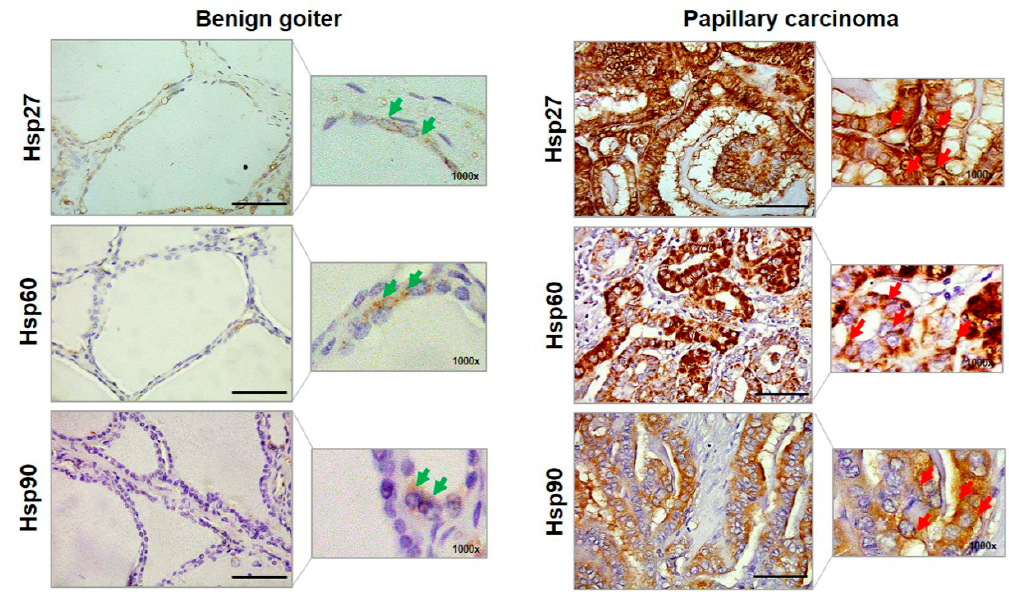
Figure 2. Representative images of the immunohistochemistry of benign goiter and papillary carcinoma for Hsp27, Hsp60, and Hsp90. Larger images were acquired at a magnification of 400× (scale bar: 100 µm); smaller images at 1000× allowed a better visualization of the cellular localization of immunopositivity . Green arrows, in benign goiter images, indicate for Hsp27 the cytosolic and perinuclear localizations; for Hsp60 the cytosolic and cytoplasmic granular (i.e., mitochondrial) localizations; and for Hsp 90 the cytosolic localization. Red arrows, in papillary carcinoma, indicate the cytoplasmic and plasma–cell membrane (or close to this membrane) localizations of Hsp27; the cytoplasmic diffuse, close to, and in plasma–cell membrane immunopositivity of Hsp60; and cytosolic and plasma cell–membrane localizations of Hsp90.